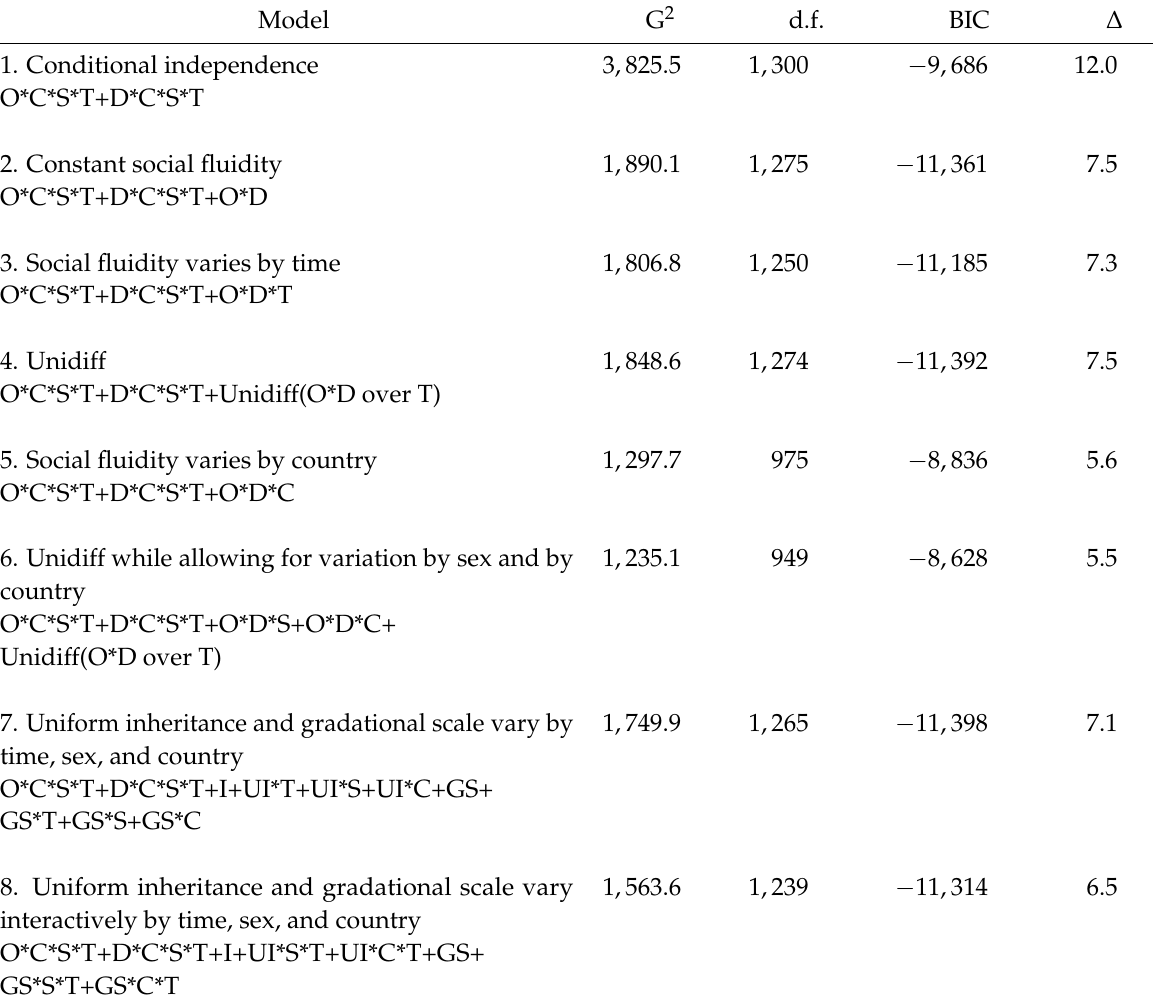
Table 2: Model fit statistics for the log-linear and log-multiplicative models.